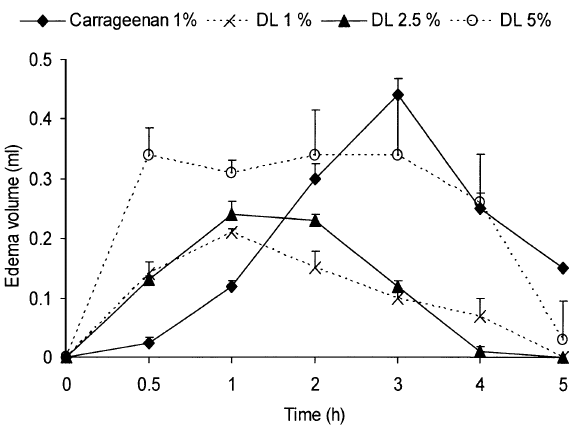
FIG. 1. Time course for inflammation induced by different doses of DL of C.proceraand carrageenan. Aqueous extracts of DL and carrageenan were injected into the subplantar surface of the rat paw and the paw volume was measured at 0, 0.5, 1, 2, 3, 4, and 5 h (n (cid:4) /